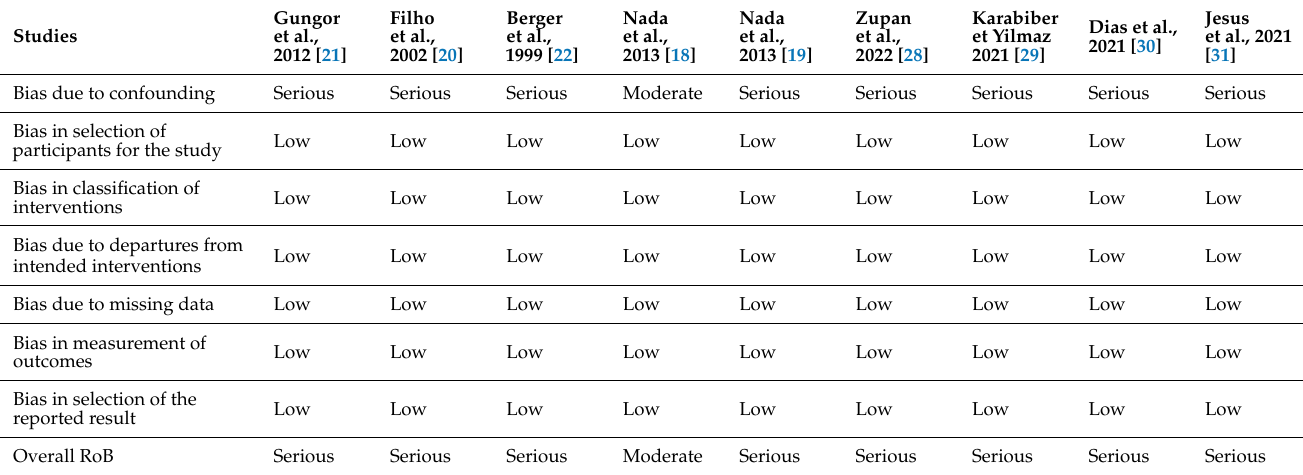
Table 5. Risk of bias summary of non-randomized